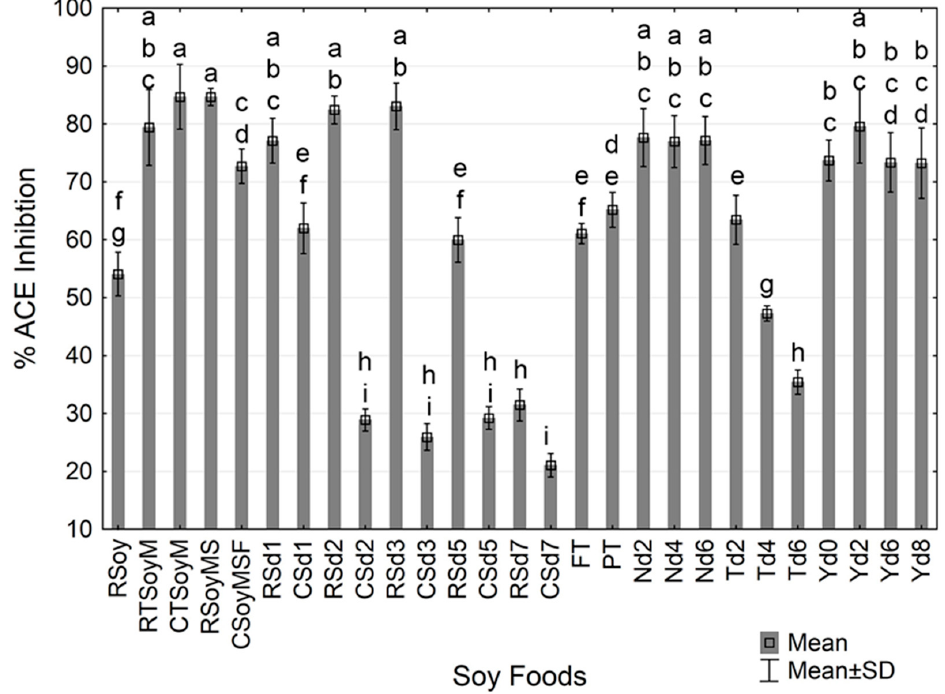
Figure 1. Percentage inhibition of angiotensin converting enzyme (ACE) of digested fermented and non-fermented soy foods. Results are expressed as the mean ± standard deviation. Sample concentration = 0.25 mg / mL in water (on dried basis). RSoy: raw soybean; RTSoyM: raw traditional soymilk;